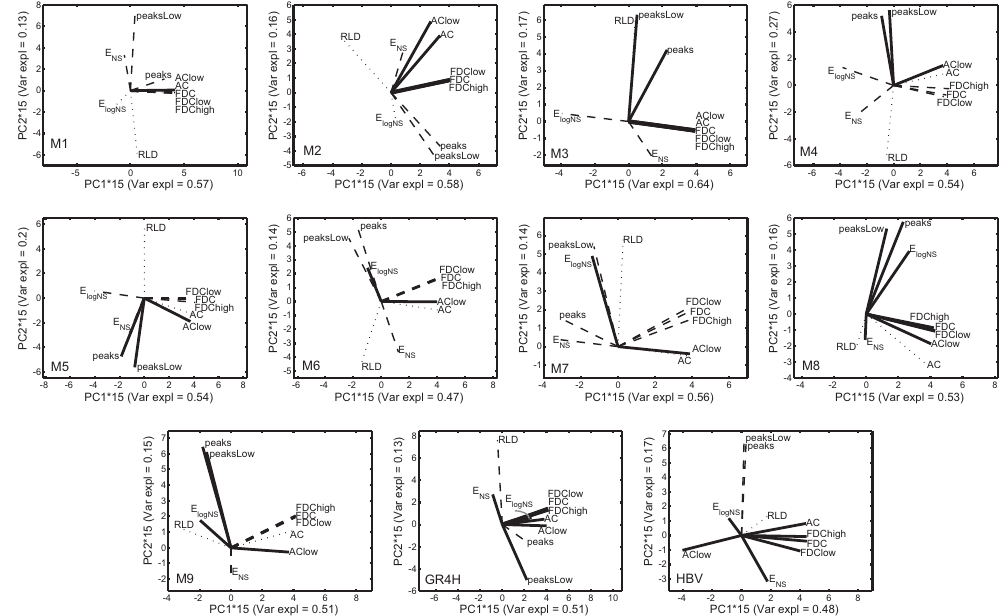
Fig. 8. Results for PCA for the Maimai catchment. Each figure represents one of the model structures. The figures are based on 1000 parameter sets. The principal components are dimensionless, because the ratios of specific signatures of the modelled and observed hydrographs are used to construct the evaluation criteria and these ratios are dimensionless. The total variance explained by these figures is the sum of the explained variance per PC.